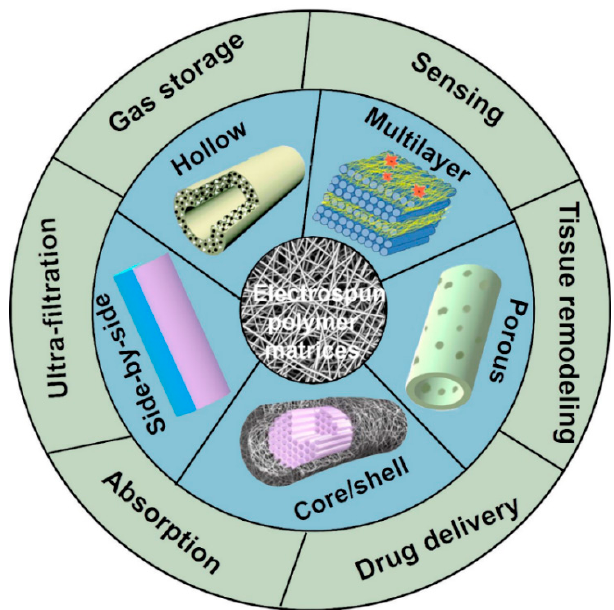
Figure 1. Possible structures and applications of electrospun fibers.